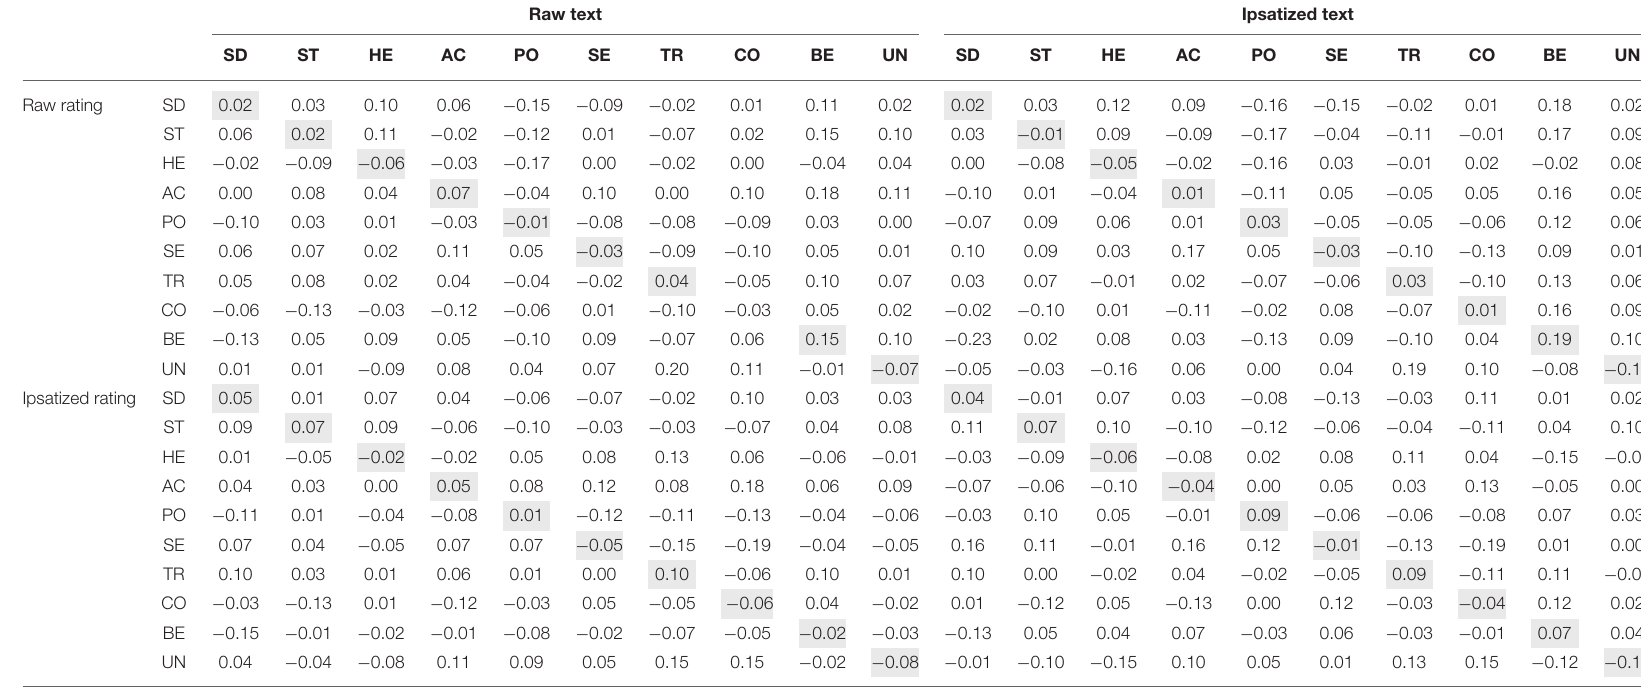
Correlations above r = 0.16 are significant at p < 0.05. SD, Self direction; ST, Stimulation; HE, Hedonism; AC, Achievement; PO, Power; SE, Security; TR, Tradition; CO, Conformity; BE, Benevolence; UN, Universalism. The meaning of the color indicates the shaded entries show value-type matched